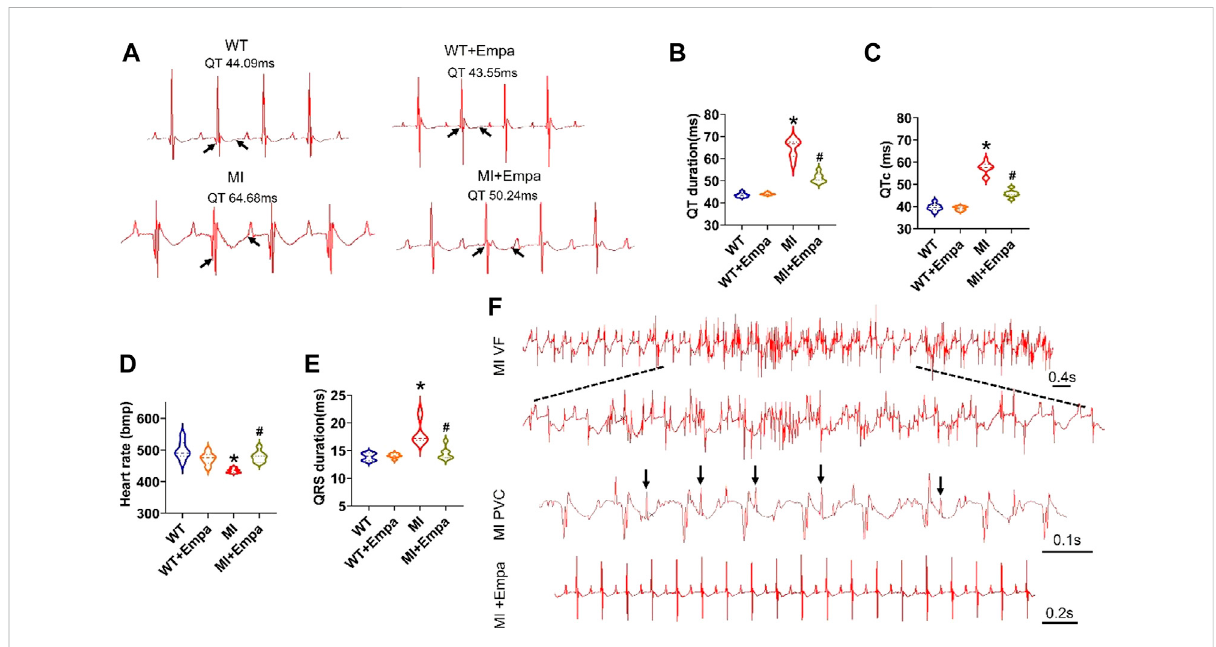
FIGURE 1 Effects of EMPA on QT interval and ventricular arrhythmias in chronic MI mice. (A,B) Representative ECG traces of the QT interval in WT, WT + EMPA, MI, and MI + EMPA. N = 6 – 10. * p < 0.05 vs . WT; # p < 0.05 vs . MI. p -values were determined using the unpaired t test. (C) QTc of WT, WT + EMPA,MI,andMI+EMPAmice.N=WT:8;WT+EMPA:6;MI:10;MI+EMPA:7;* p < 0.05vs . WT;and # p < 0.05vs . MI. (D,E) heartrateandQRSofWT, WT+EMPA,MI,andMI+EMPAmice.N=6 – 9;* p < 0.05vs . WT;and # p < 0.05vs . MI. (F) RepresentativeECGtracesoftheVFandPVCsinMIand MI + EMPA